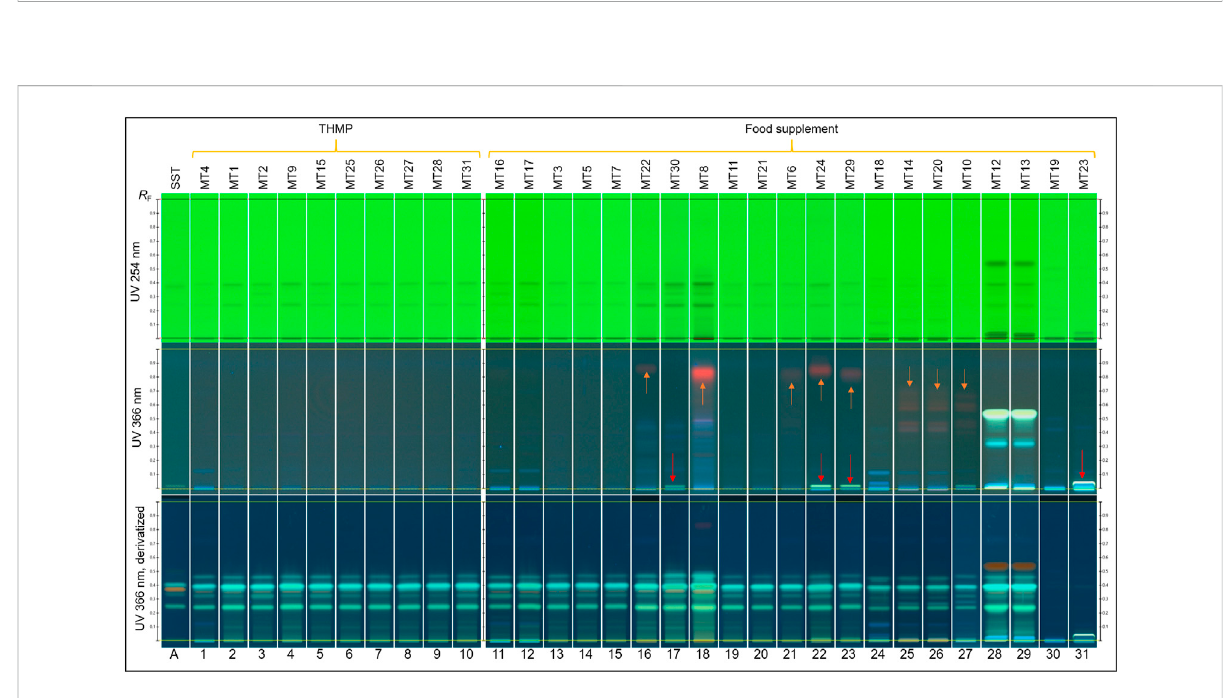
FIGURE 2 Fingerprints of the 31 milk thistle products in different detection modes, grouped by regulatory categories. Track A: silydianin, silychristin, taxifolin, and silybin in increasing R F values. Orange arrows: red zone due to chlorophyll detected in some products; red arrow: an unidenti fi ed yellow-white zone detected in some